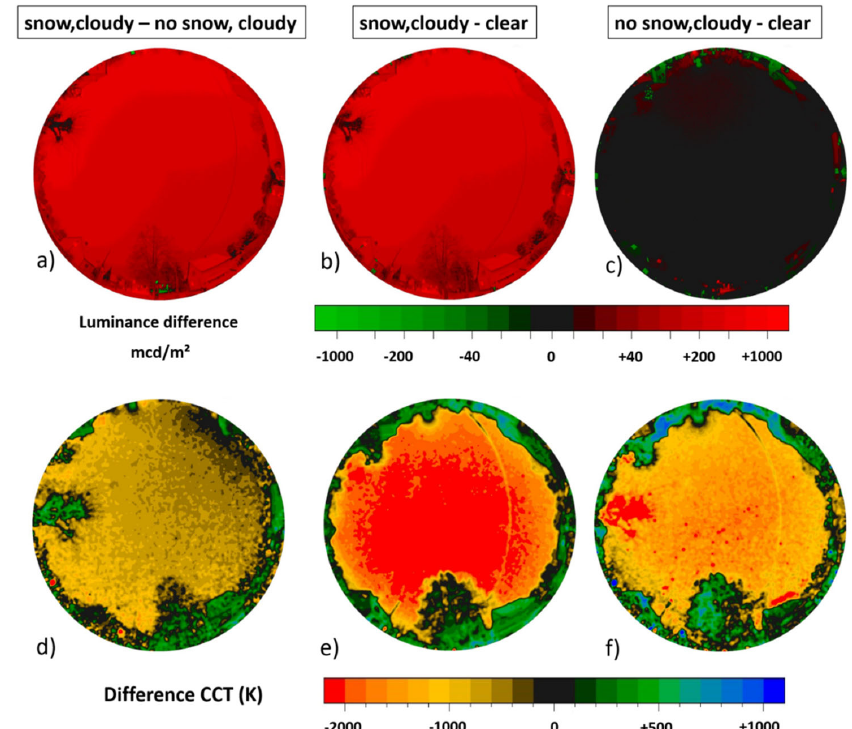
Figure 5. Difference in imaging data between three winter nights in the suburban area in the town of Ludwigsfelde (see Figure 4). Panels ( a,b,c ) show subtracted luminance data and panels ( d,e,f ) show subtracted CCT data. The left column ( a,d ) shows data obtained by subtracting imaging data of